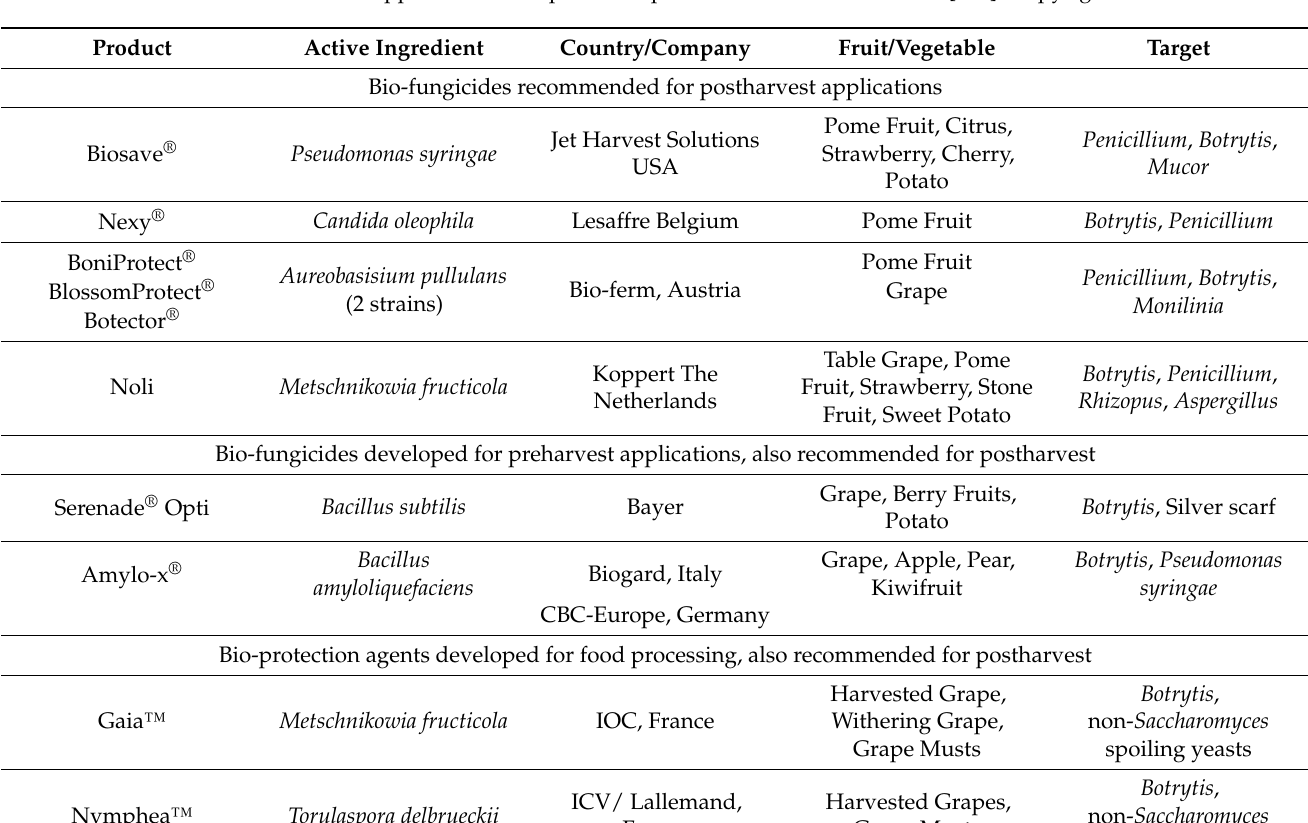
Table 2. A non-exhaustive list of biocontrol-based products that are currently marketed for posthar- vest applications. Adapted with permission from Sellitto et al. [123]. Copyright 2021